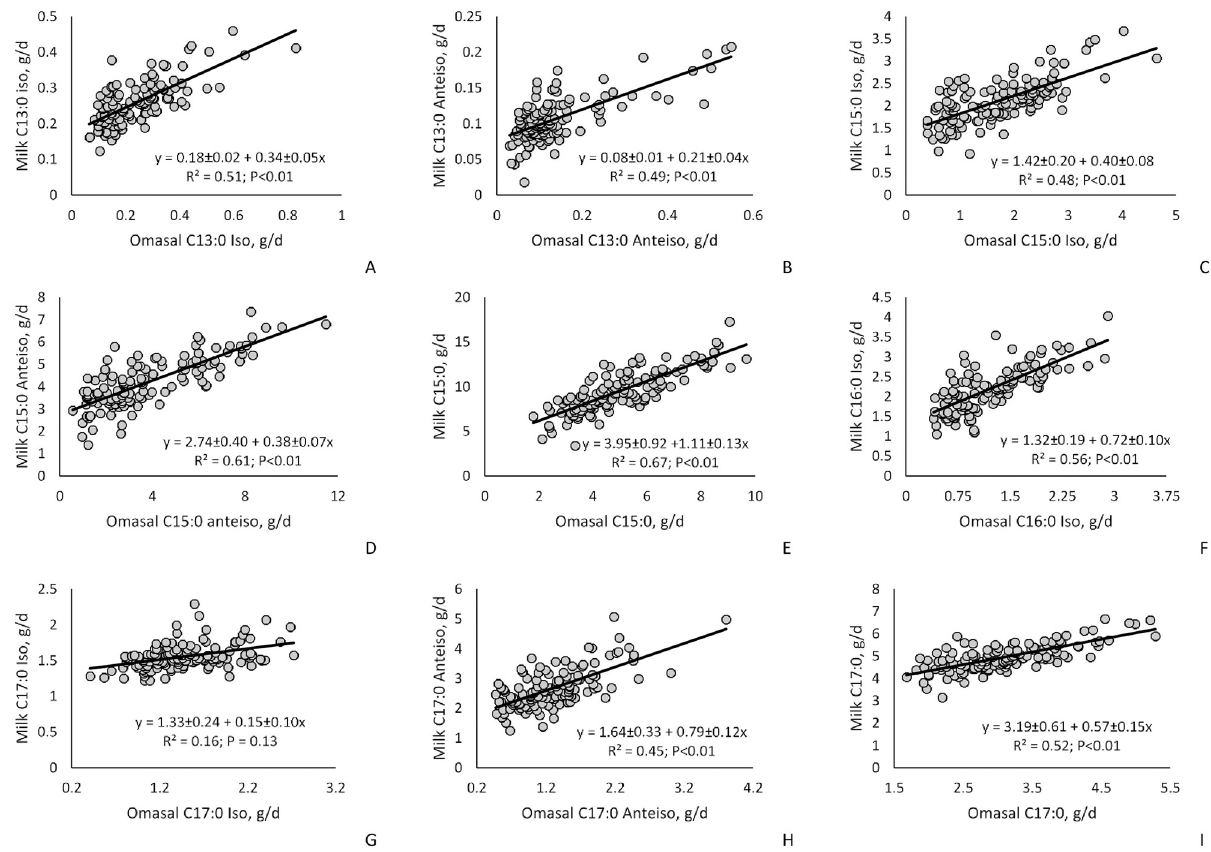
Fig 3. Influence of omasal fatty acid (FA) flow (g/d) on milk fatty acid yield (g/d) estimated by univariate mixed model regression analysis (OBCFA = A + BX 1 ) in dairy cows.